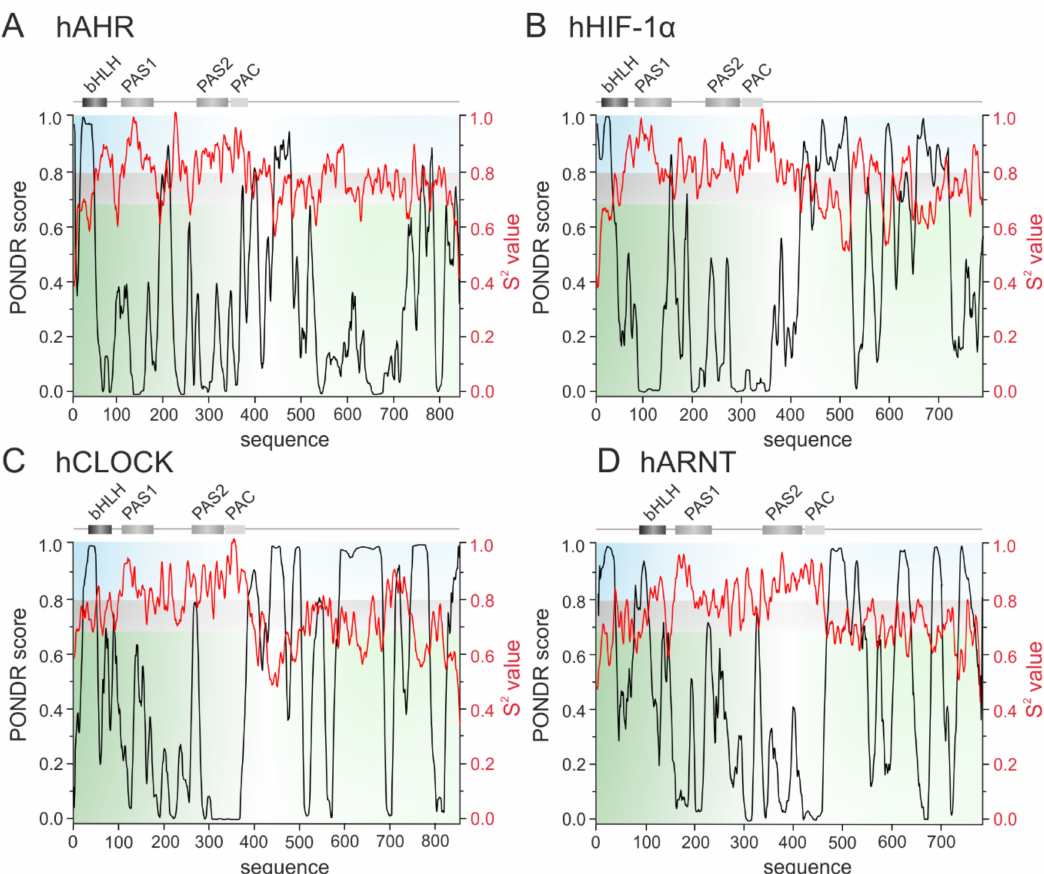
Figure 3. Prediction of intrinsically disordered regions of the class VII bHLH-PAS proteins. The top panel presents the domain structure of the analyzed bHLH–PAS proteins. Dark grey rectangle indicates the bHLH domain, light grey indicates PAS / PAC domains. The bottom panel presents a prediction of intrinsically disordered and flexible regions based on the amino acid sequence of proteins. Prediction were performed using PONDR-VLXT (left Y axis) and DynaMine (right Y axis) software. For PONDR prediction, score above 0.5 indicate disorder. For Dynamine, a S 2 value above 0.8 (blue zone) indicates rigid conformation, 0.69–0.8 (grey zone) is context dependent and a value below 0.69 (green zone) indicates flexible conformation. ( A ) human AHR [P35869], ( B ) human HIF-1 α [Q16665], ( C ) human CLOCK [O08785], ( D ) human ARNT